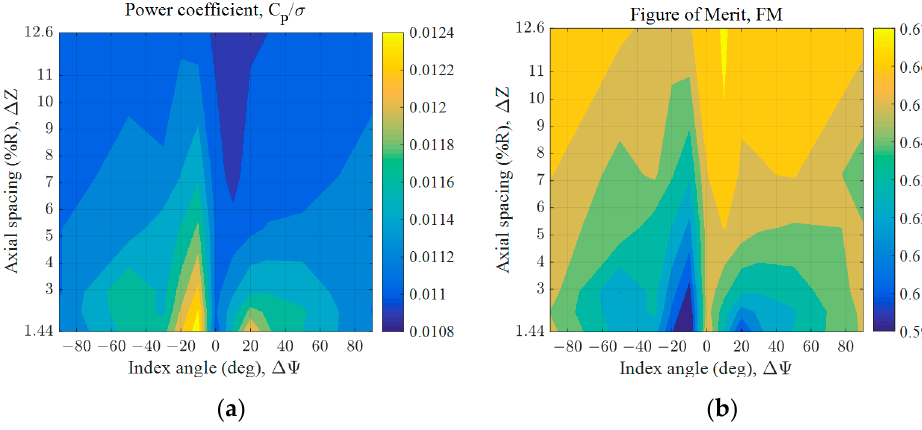
Figure 13. Hover performance analyses with respect to various index angles and axial spacings ( C T = 0.0102): ( a ) Power ( C P / σ ); ( b ) Figure of Merit